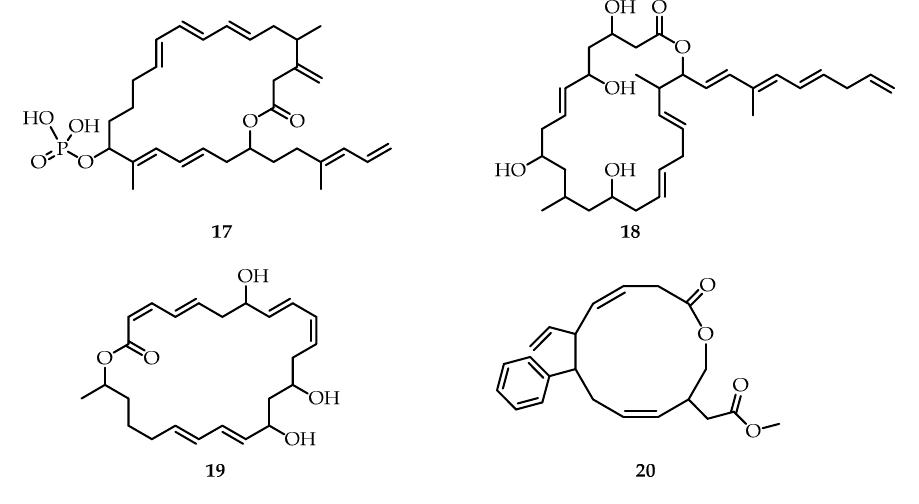
Figure 6. Structures of polyketides 17 - 20 .